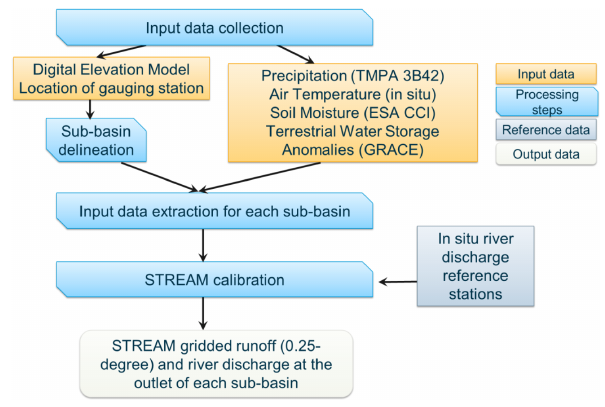
Figure 3. Processing steps of the STREAM